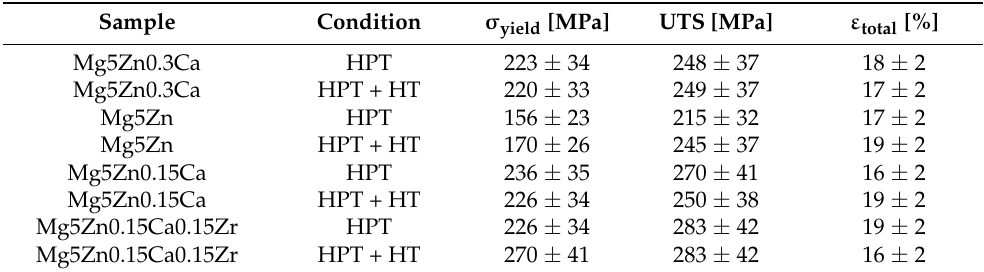
Table 3. Measured yield strength σ yield and ultimate tensile strength (UTS), as well as ductility (total elongation) ε total for all tested alloys in all conditions (‘HPT’ at 4 GPa, 10 rotations at 285 ◦ C and heat treatment ‘HT’ at 100 ◦ C for 24 h).